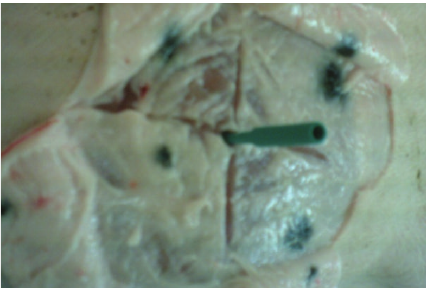
Figure 2: Sampling of the injection point 6 weeks after injection. Six weeks after injection, the injection point was localized as done at the injection time (Figure 1). The two lines were drawn thanks to the four tattooed points. After removing the skin and the fat layer, the portion of the injected muscle was sampled using a disposable 2 cm long biopsy punch that was horizontally applied on the muscle